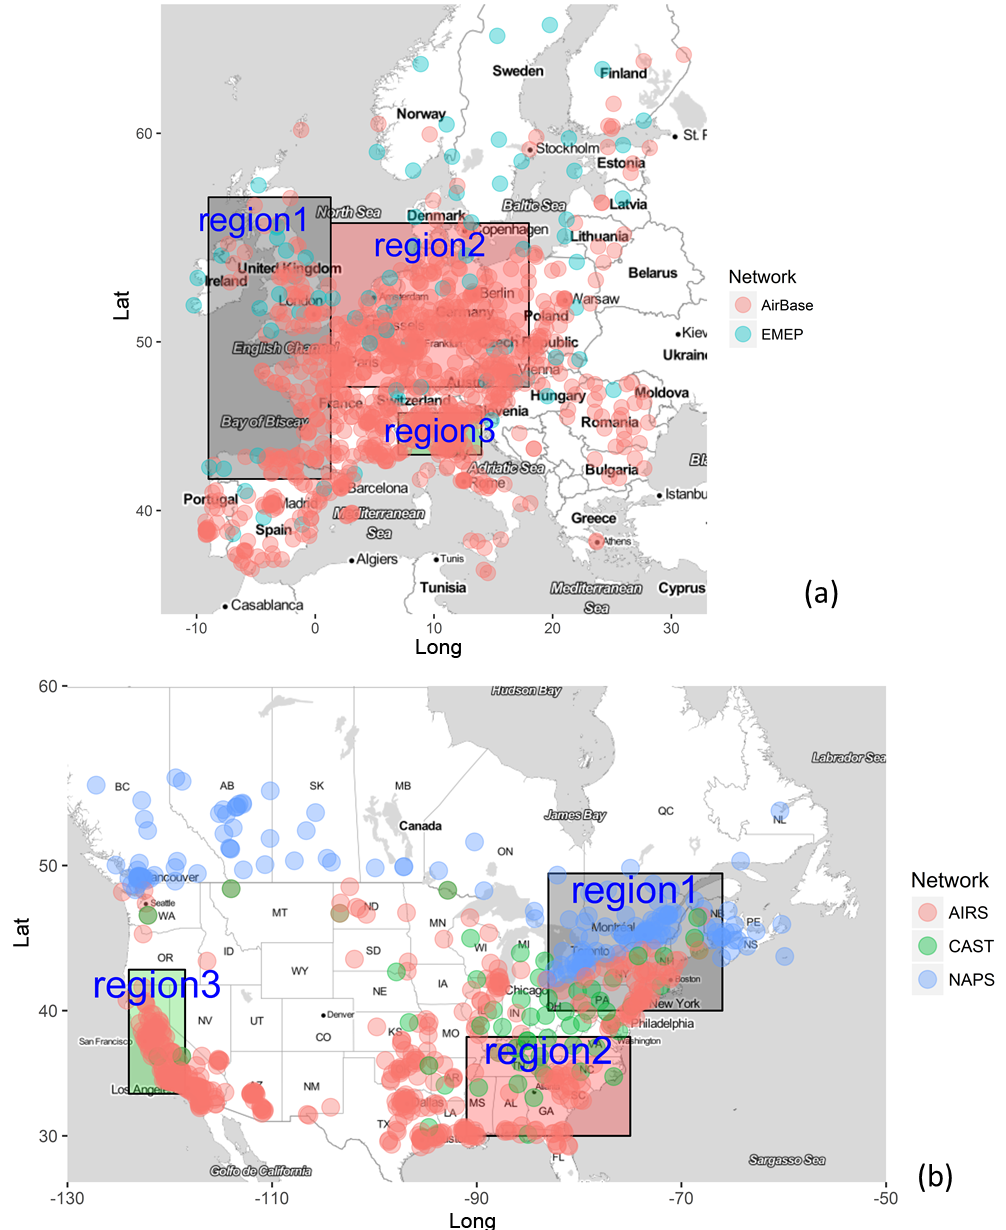
Figure 1. Subregions of the two continental domains (a) EU and (b) NA. Overlaid are the ozone monitoring stations classified based on the